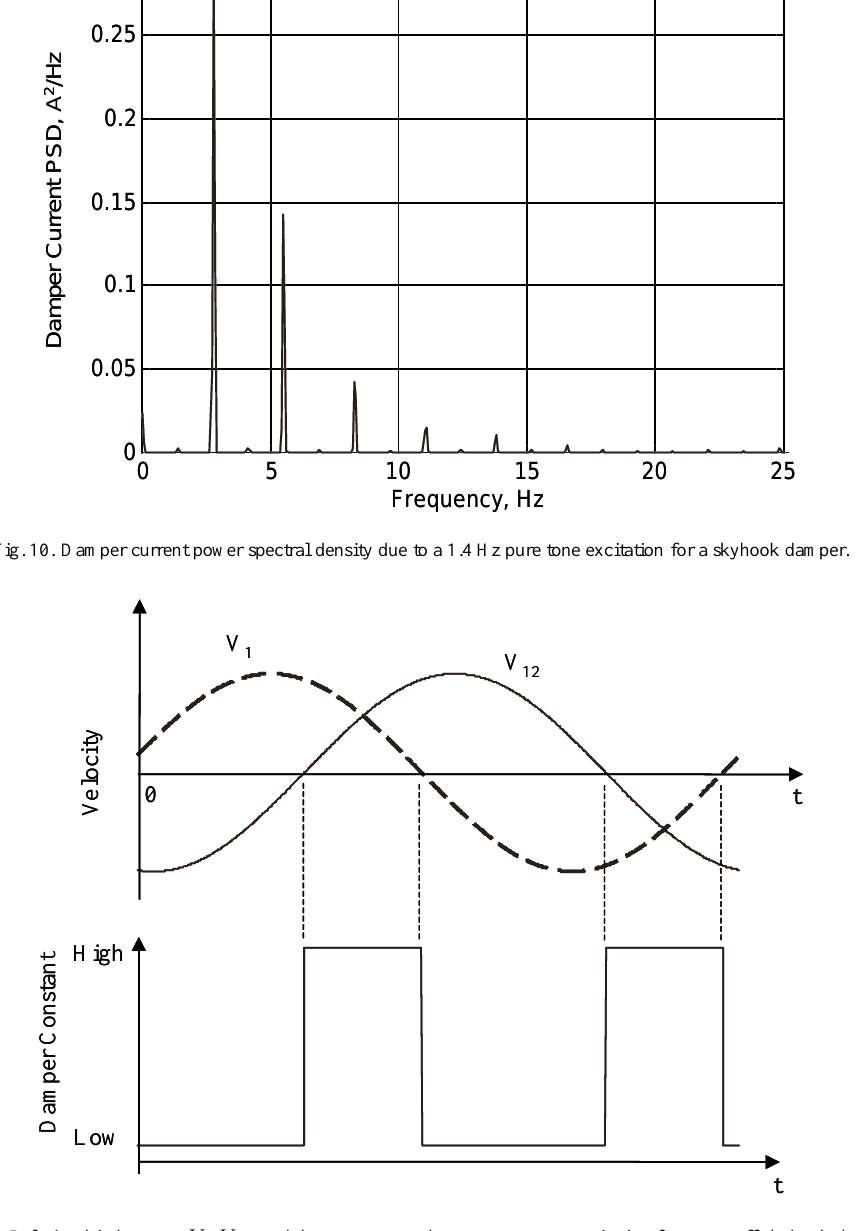
Fig. 11. Relationship between V 1 , V 12 , and damper current due to a pure tone excitation for an on-off skyhook damper. off damper, it was determined that the damping con- across the damper. Extending this concept to a con- stant (or damper current, in case of magneto rheologi- tinuously variable skyhook damper, it was shown that there exits two zero crossing of the absolute velocity cal dampers) switches between the low and high state at twice the frequency of the driving frequency, due to during each relative velocity cycle. This gives rise to two cycles of the damper force for each cycle of the the phase shift that always exists between the absolute velocity of the sprung mass and the relative velocity relative velocity. In each of its cycles, the damper